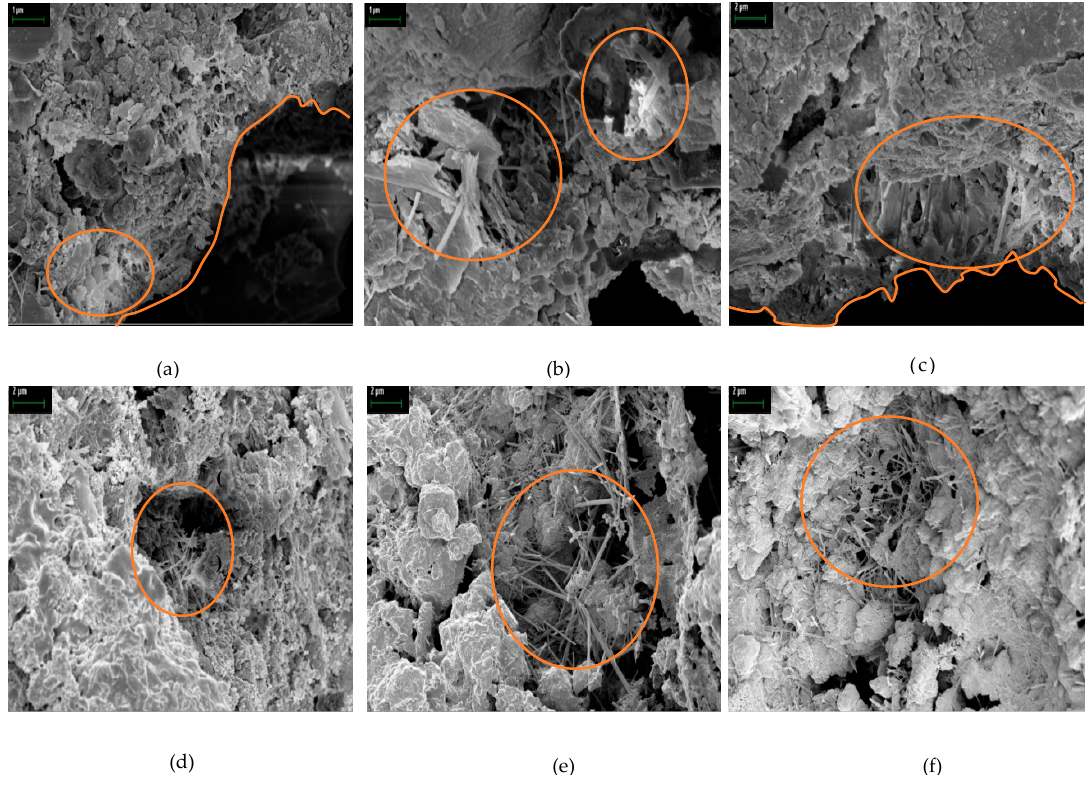
Figure 14. SEM micrographs of healing products on the crack surface (repaired by C.R.S 3), the scale is shown on top right corner of each figure, scale is 1 μ m for ( a , b ) while 2 μ m for ( c – f ).